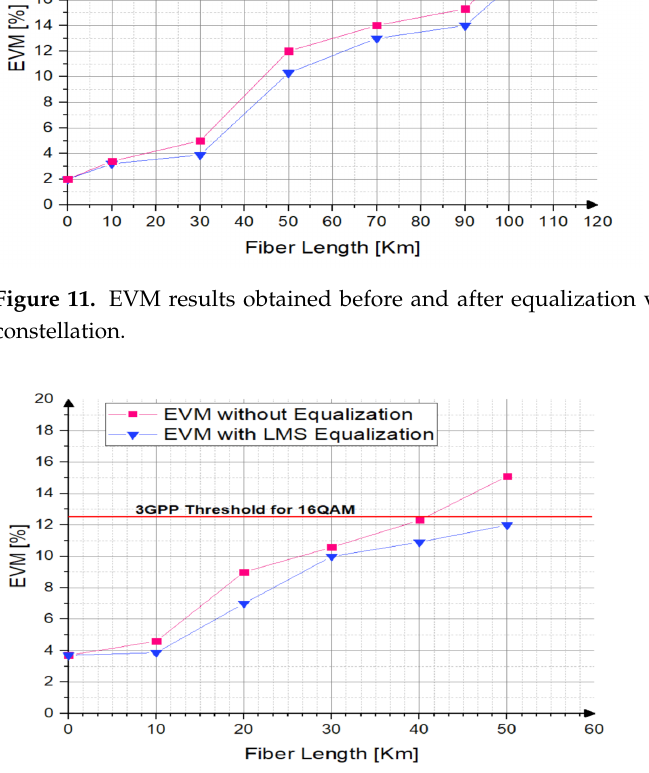
Figure 12. EVM results obtained before and after Least Mean Square (LMS) equalization vs. the fiber lengths for a 16QAM